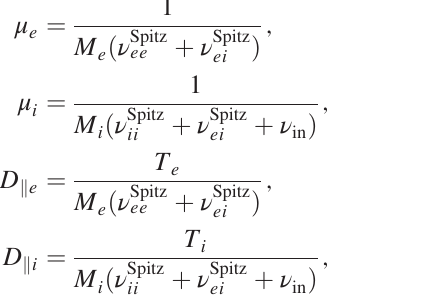
FIG. 8. Proton confinement time ¯ τ empirical approach is supported by the comparison with the two borderline values of theoretical confinement time. ¯ τ theor 1 ¯ τ theor 2 in the largest part of H þ